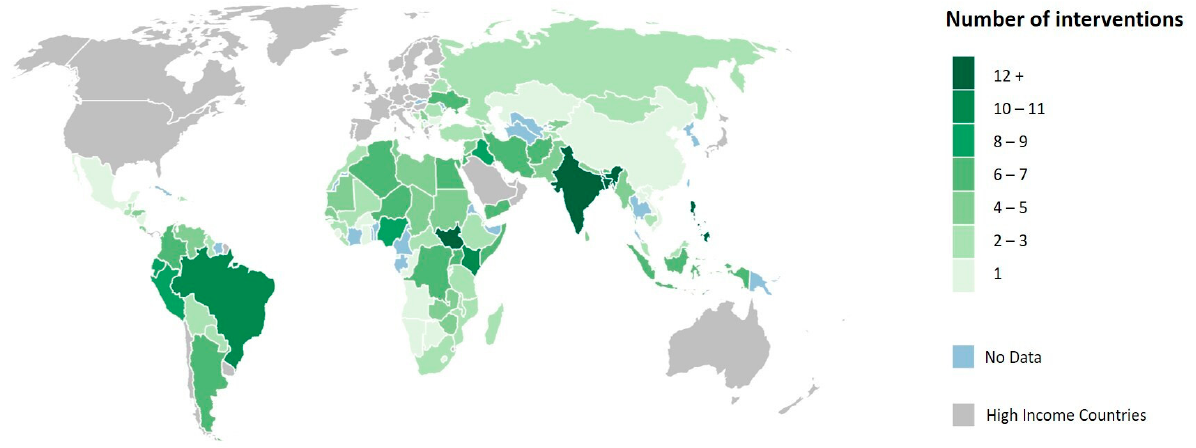
Figure 1. Map showing the geographic distribution of food security interventions implemented in low- and middle-income countries by select INGOs and UN agencies in the context of COVID-19.